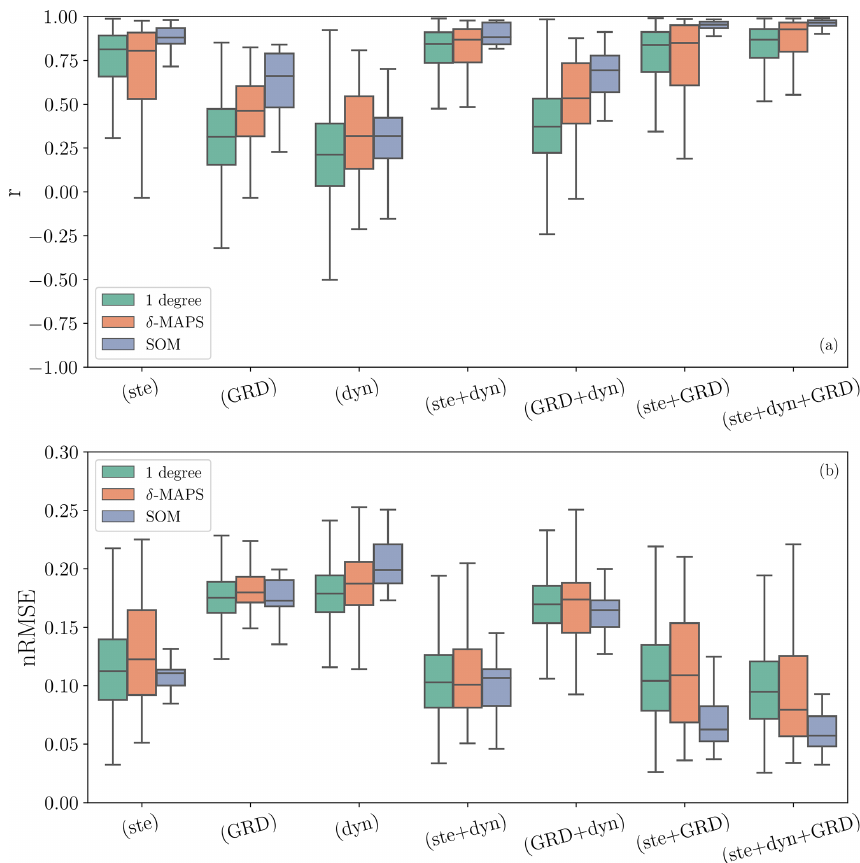
Figure 5. The effect on budget closure for different component combinations and spatial resolutions. (a) Pearson’s correlation coefficient ( r ) and (b) normalized root-mean-squared error (nRMSE) (in mmyr − 1 ) between total sea-level (altimetry) and the different components included in the budget ( x axis) for the different spatial resolutions (1 ◦ in green, δ -MAPS in red, and SOM in blue). Boxes represent the quartiles of the distribution, extending from the lower to upper quartile values of the data, with a line at the median, while the whiskers (not error bars) show the full